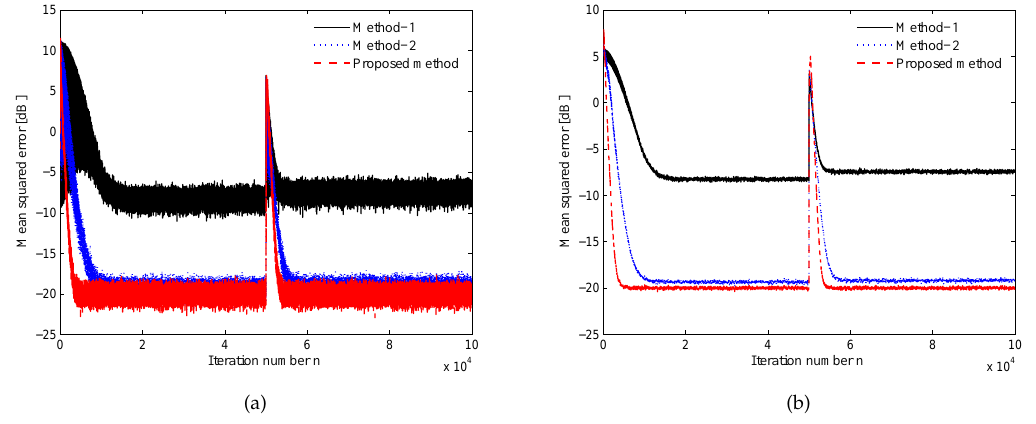
Figure 10. Comparison between the residual errors of Method 1, Method 2, and the proposed method for the variable acoustic path S ( z ) shown in Figure 4. ( a ) Mean square error E [ e 2 ( n )] . ( b ) Mean square error E [ e 2 ( n )] obtained by averaging the square values of 50 past residue errors.